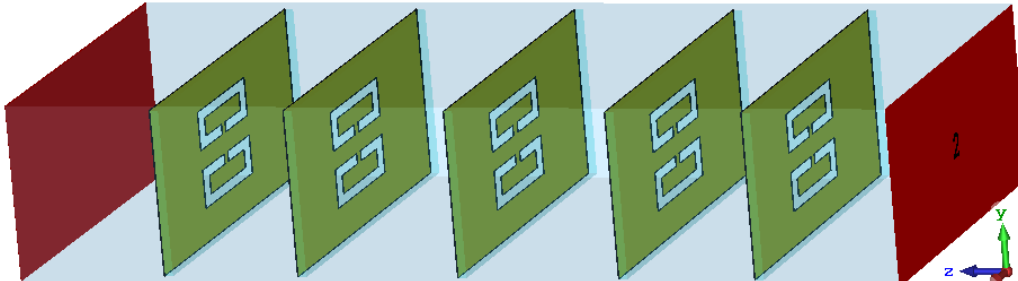
Figure 15. Final design of the proposed waveguide meta-resonator filter N = 5 for X-band at resonant frequency 10 GHz.